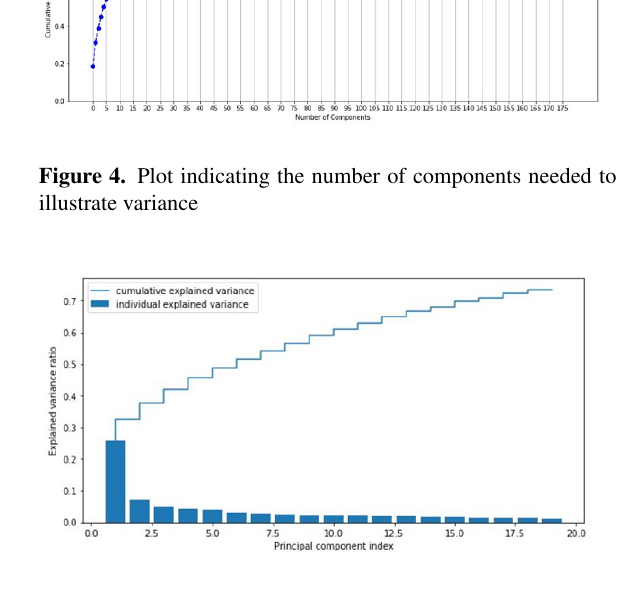
Figure 5. Plot of ‘Explained variance ratio’ vs ‘Principal com- ponent index’